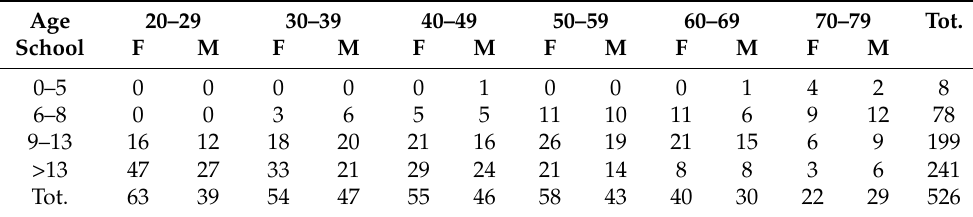
Table 1. Demographic characteristics of the participants’ sample. F = female; M = male.